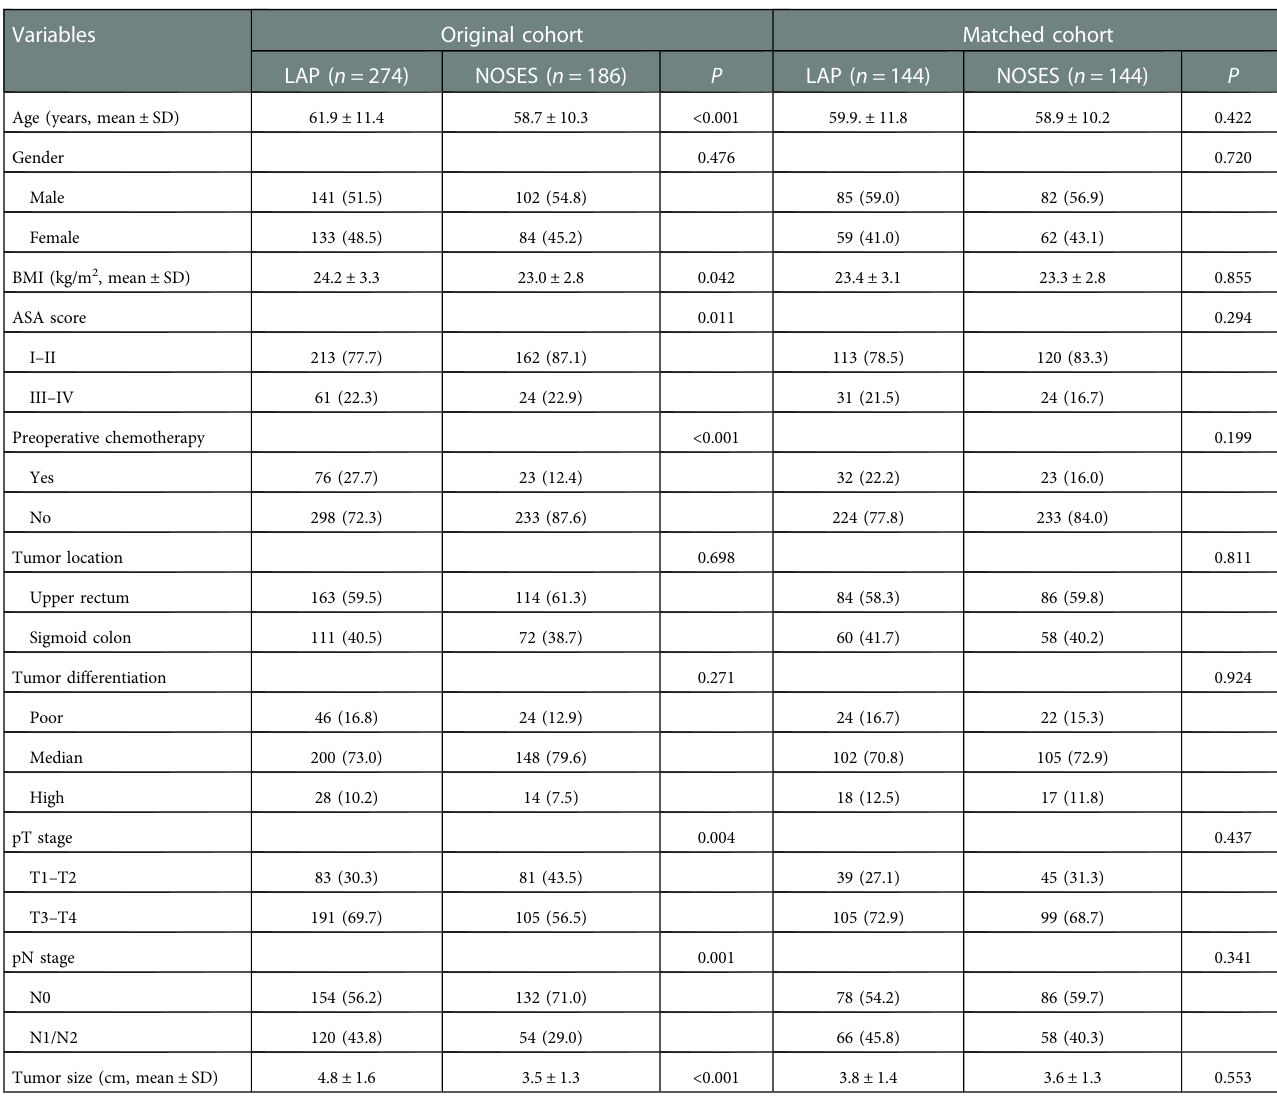
TABLE 1 Clinical and pathologic characteristics before and after PSM.